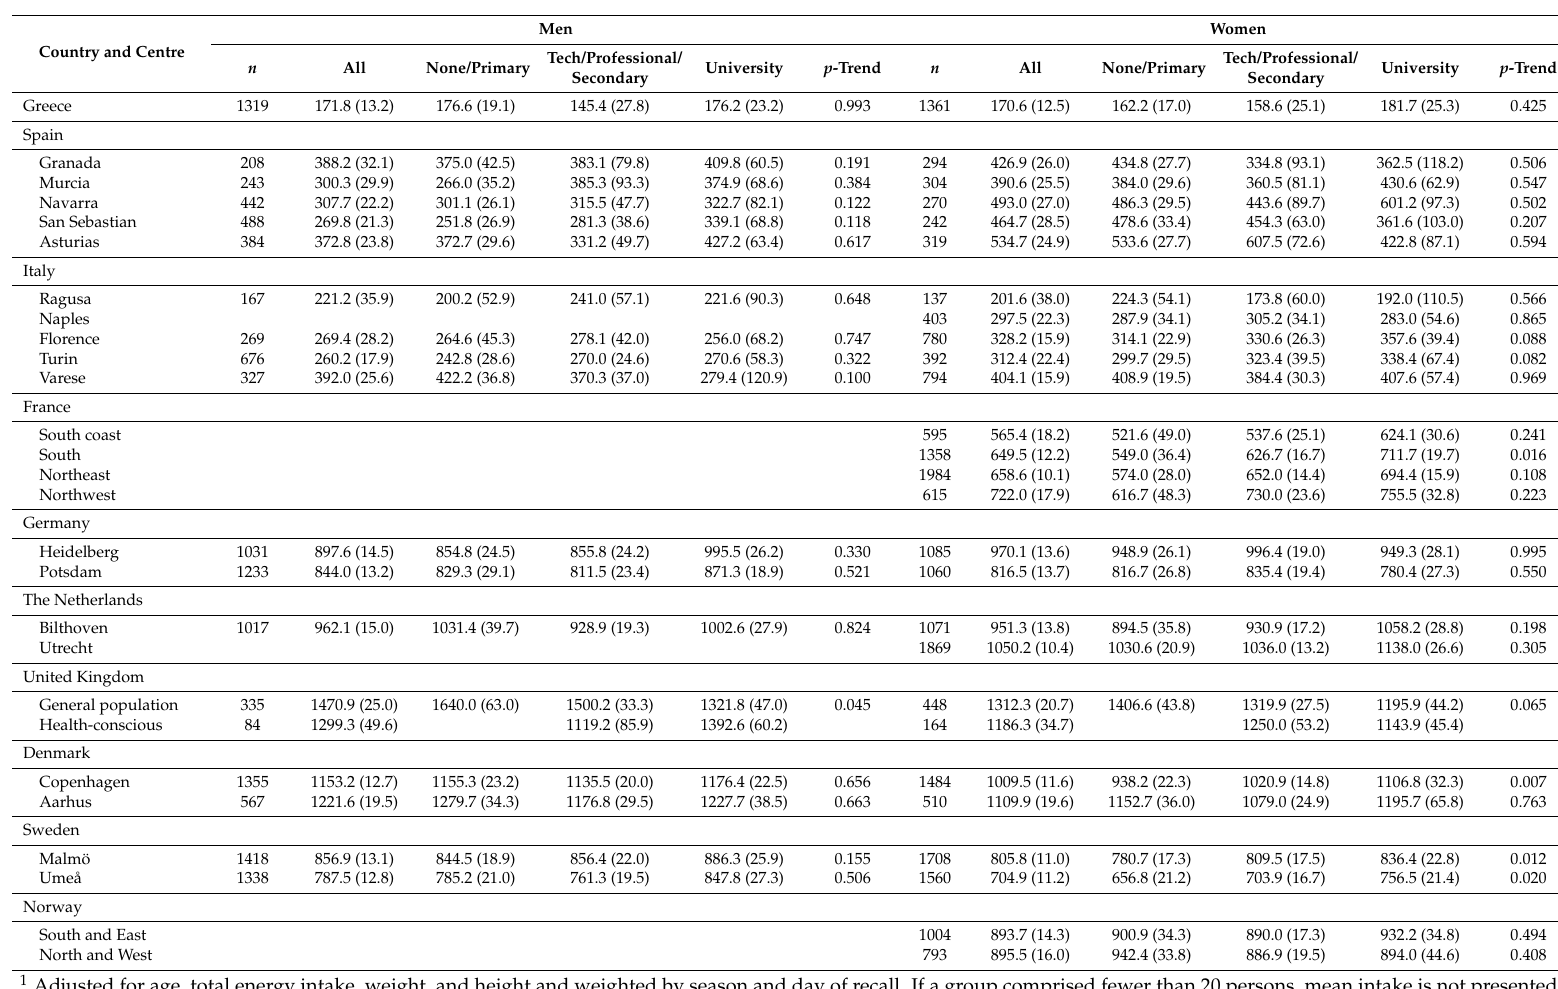
Table 4. Fully adjusted mean 1 daily intake of coffee and tea (g/day) by education level and sex in the EPIC calibration study population based on 24-H Dietary Recall across EPIC centres ordered from south to